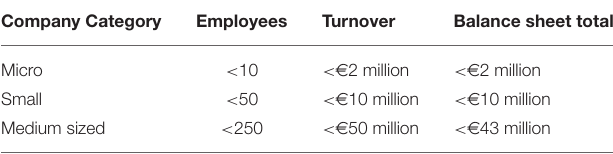
TABLE 1 | Definition of SMEs. Company